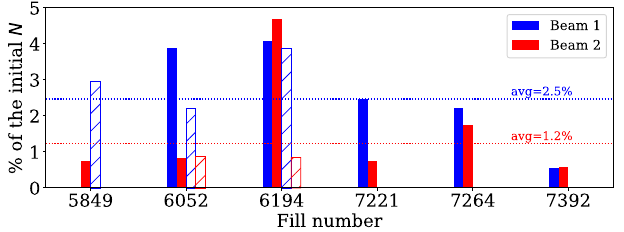
FIG. 10. Integrated intensity lost during the experiments. The data show the intensity reconstruction for the vertical (solid bar) and horizontal (hatched bar) plane for beam 1 (blue) and beam 2